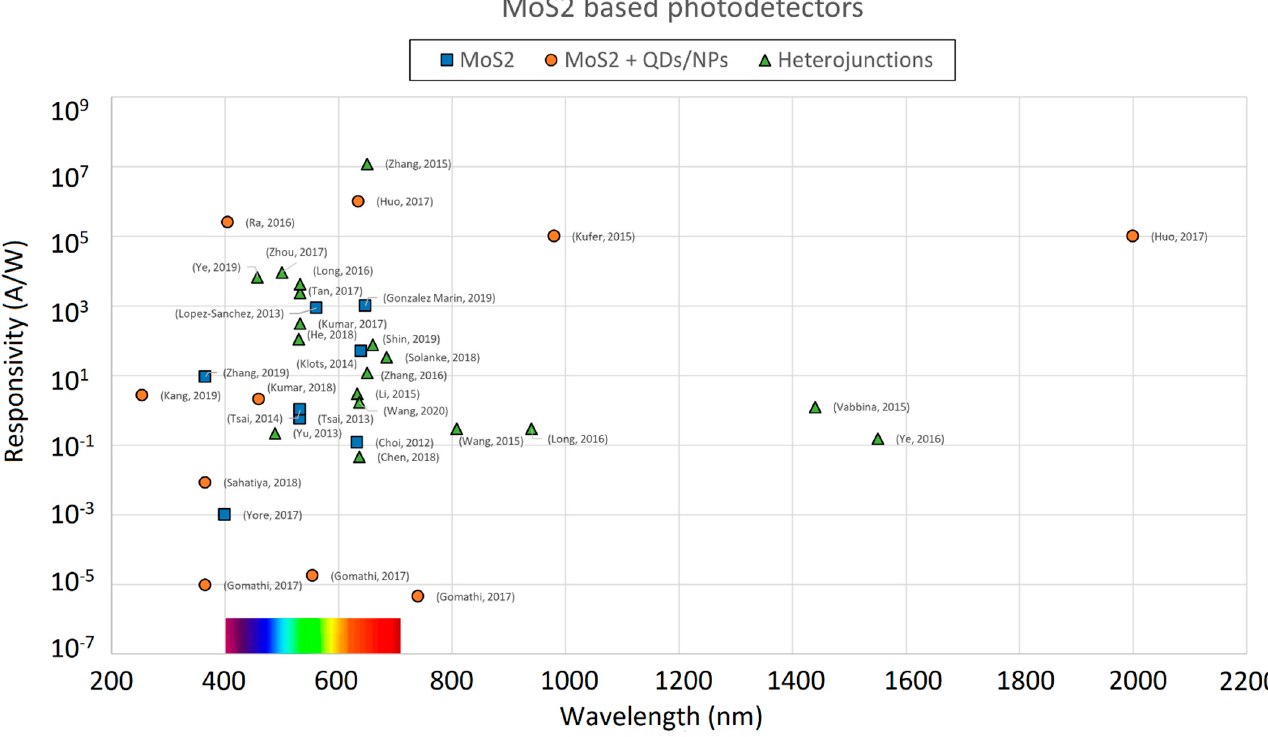
Figure 10. Responsivity values plotted against the wavelength for various MoS2-based